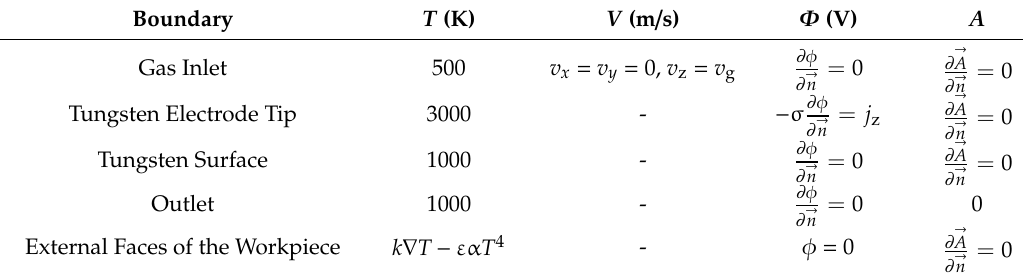
Table 1. The external boundary